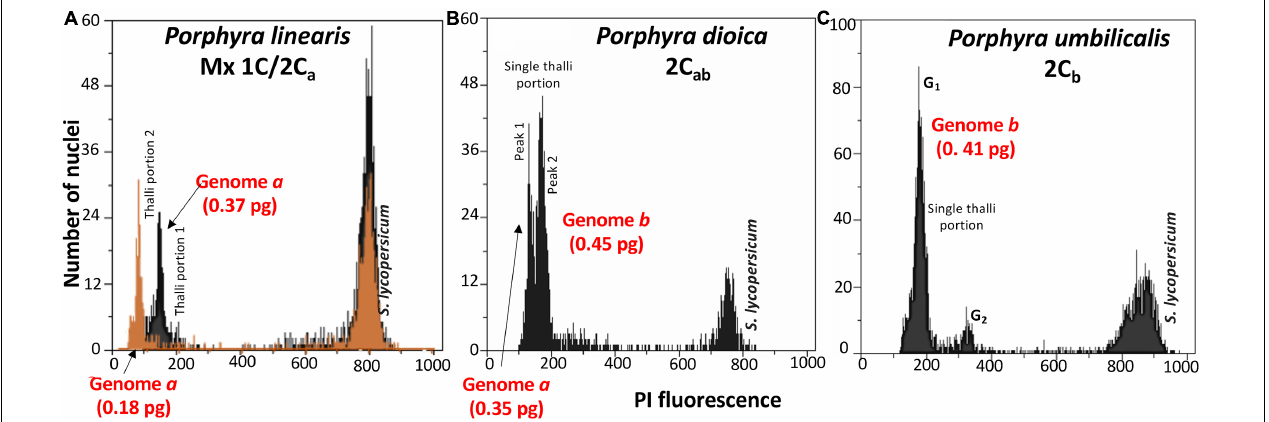
FIGURE 3 | Flow cytometric histograms of relative fluorescence intensities of propidium iodide-stained nuclei in vegetative thalli of Porphyra , internal reference standard Solanum lycopersicum (peak at the right; with 2C = 1.96 pg): (A) Superimposed flow-cytometric histograms for two thallus sections in the same blade in P. linearis with two distinct genome sizes, demonstrating the sectorial distribution of the genome sizes, (B) Two genome sizes in a single thallus portion in P. dioica , (C) Genome size of genome type b in P. umbilicalis . TABLE 3 | Cytotype diversity in each Porphyra spp. Vegetative P. umbilicalis Vegetative P. linearis Vegetative P. dioica Thallus sections Blades Thallus sections Blades Thallus sections